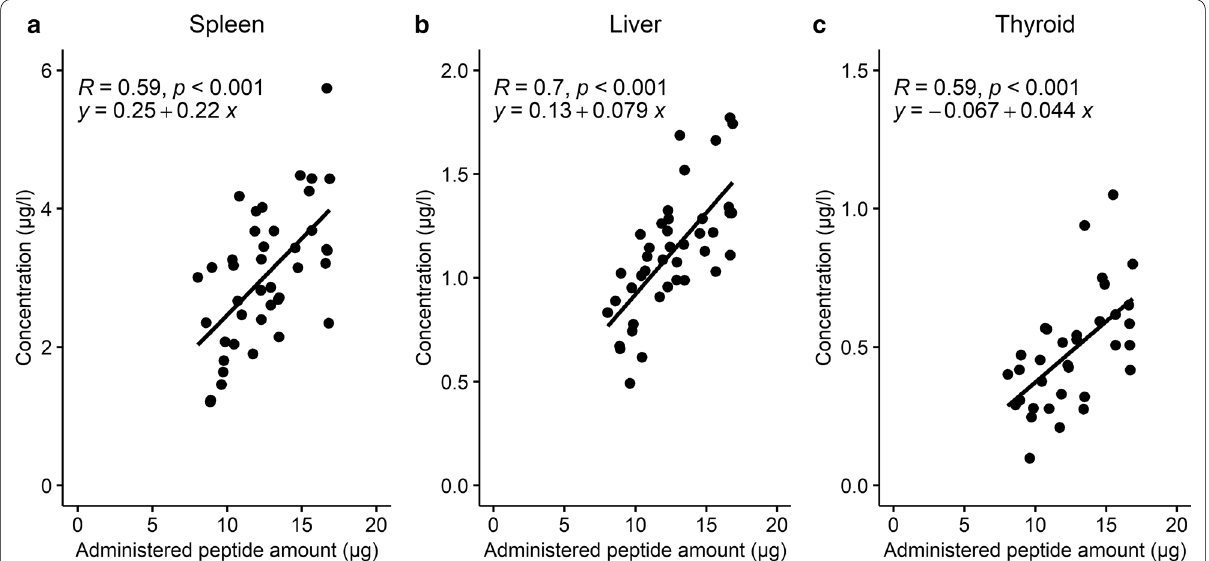
Fig. 3 Observed peptide uptake (µg/l) for spleen ( a ), liver ( b ) and thyroid ( c ) versus administered DOTATATE amount (µg) for 41 patients without neuroendocrine tumors, where a correlation was observed that higher administered peptide amounts seem to result in increased uptake in these organs